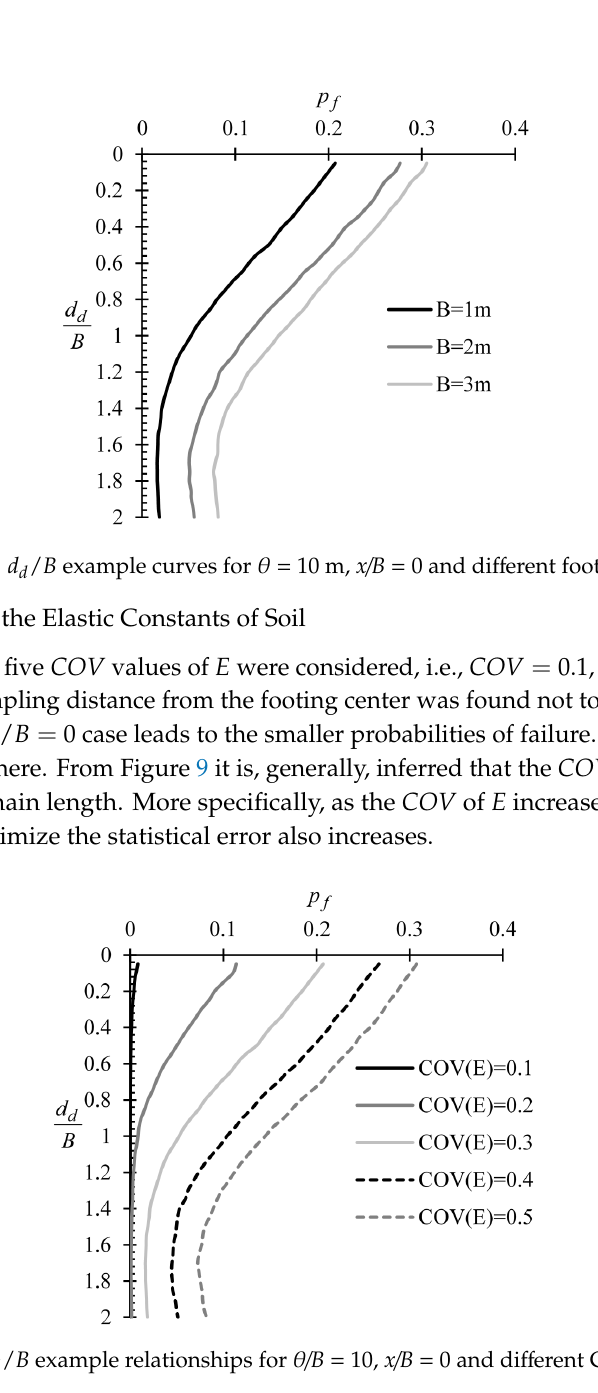
Figure 9. vs. d d / B example relationships for θ / B = 10, x / B = 0 and di ff erent COV values of E Figure 9. versus example relationships for θ /B = 10, x/B = 0 and different COV values of E . d d B